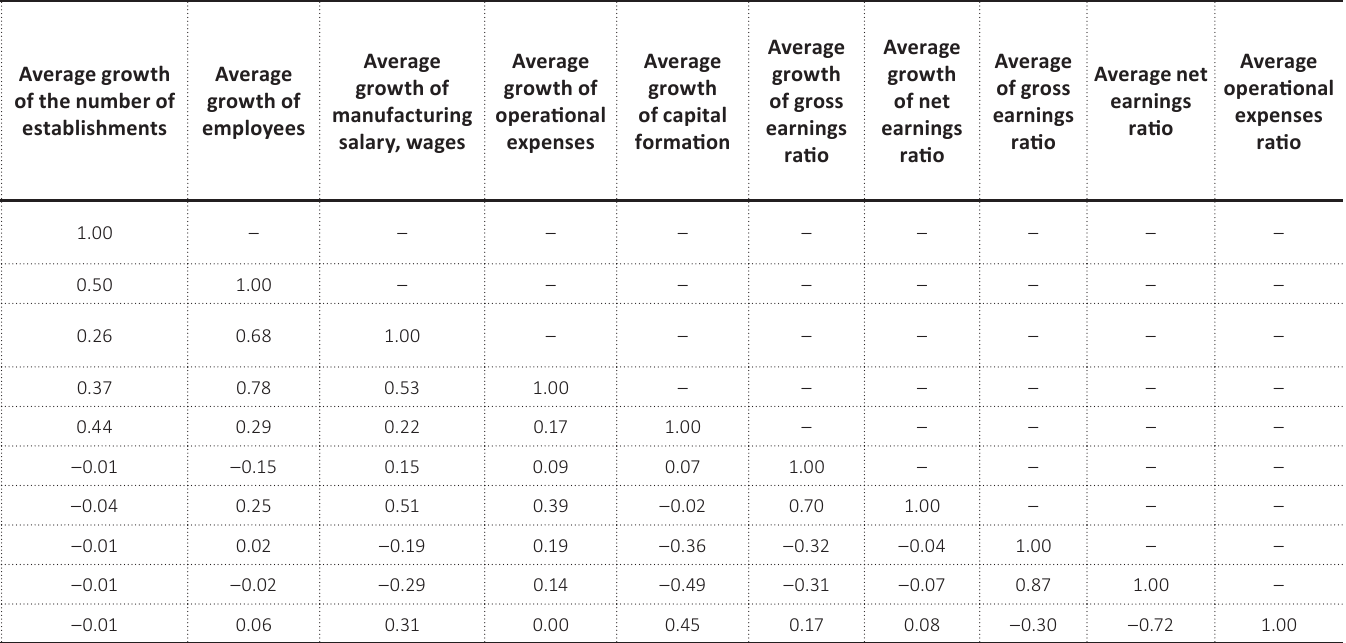
Table B1. Multiple correlations among growth in all manufacturing establishments (activity-wise) and average gross earnings, net earnings, and operational